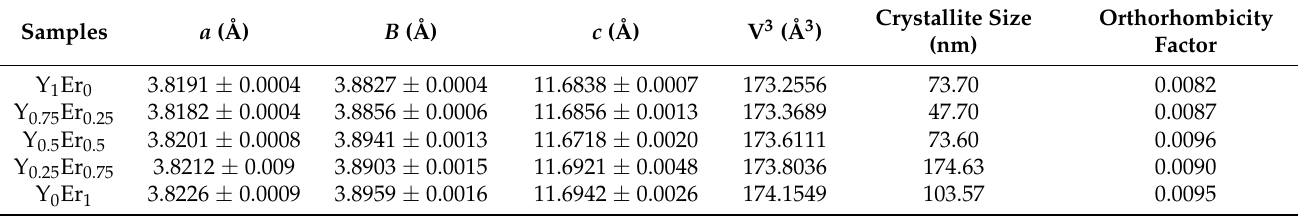
Table 1. Lattice parameters of a , b, and c axes and unit cell volume of YBCO with different ratios of Y123:Er123.